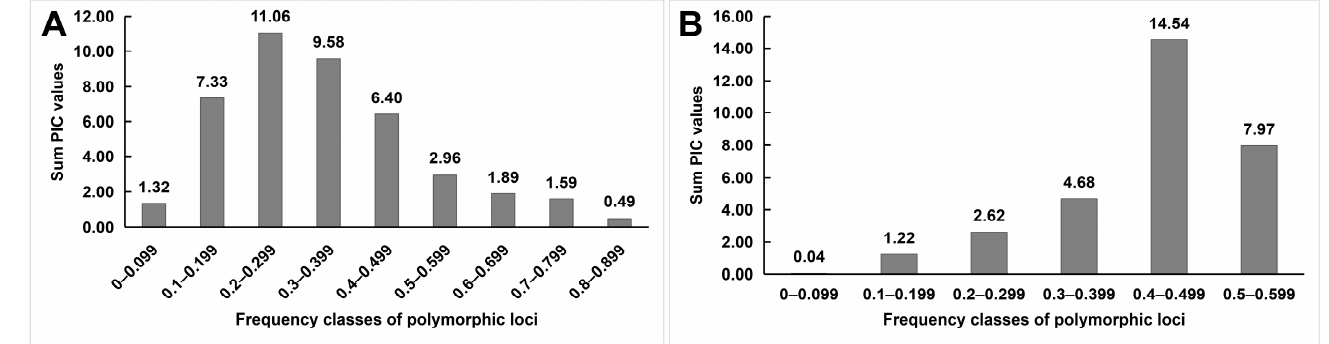
Figure 3. The relationship between the frequency of polymorphic loci and the total PIC value, which